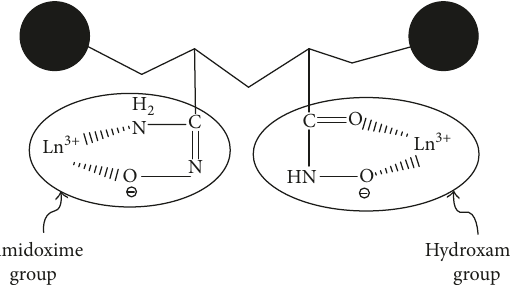
Scheme 2: Lanthanide metal ions adsorption modes.